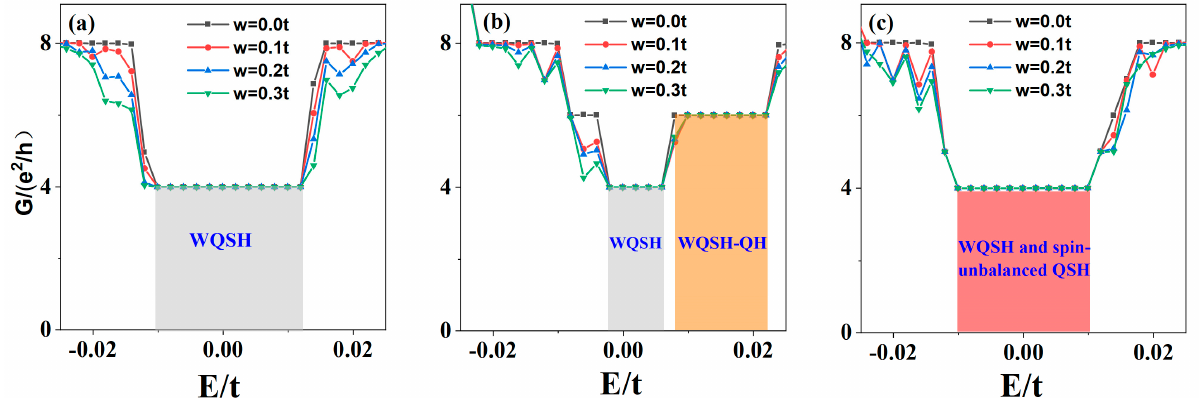
Figure 6. Effect of disorder on the WQSH phase. The conductance G as a function of Fermi energy E for the different disorder strengths W with ∅ (cid:3404) 0.002 and M = 0.02t for ( a ) E = 0, V 1 = − V 2 = 0; ( b ) E = 8.8 × 10 6 V/m, V 1 = − V 2 = 0; ( c ) E = 0, V 1 = − V 2 = 0.02t.